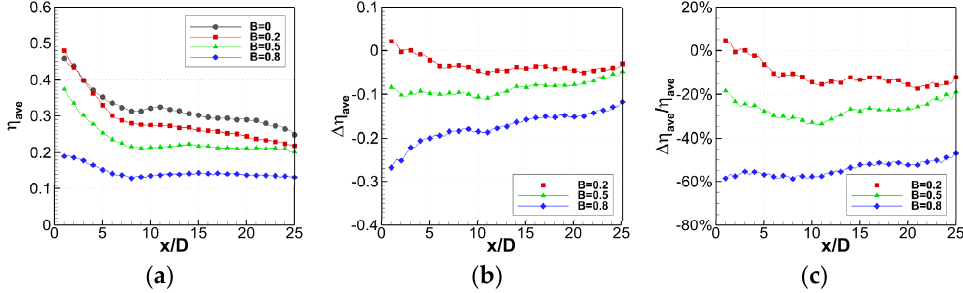
Figure 13. Effect of blockage ratio on spanwise averaged film effectiveness at M = 1.4. ( a ) η ave ; ( b ) ∆ η ave ; ( c ) ∆ η ave / η ave .